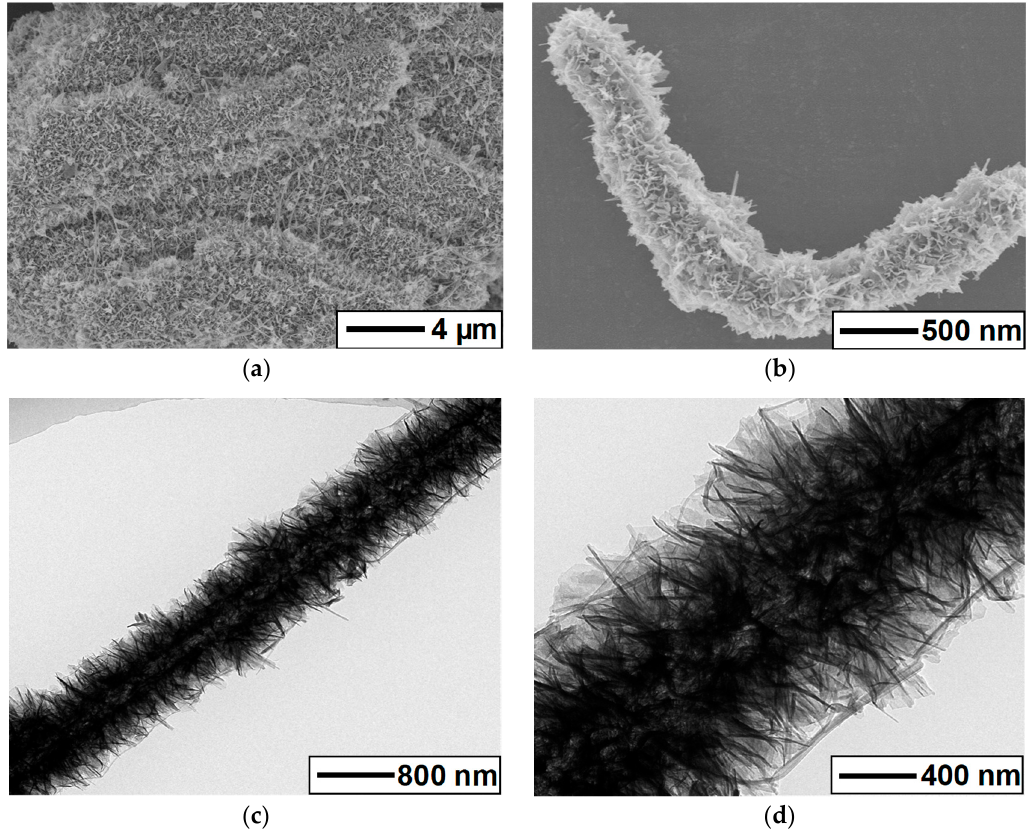
Figure 3. Electron micrographs of the MnO 2 -carbon-40.15% nanocomposite derived from a natural cellulose substance. ( a ) FE-SEM image of the sample, displaying nanofiber assemblies. ( b ) An individual composite nanofiber isolated from the assemblies. ( c , d ) The TEM images of an individual MnO 2 -carbon-40.15% nanofiber at different magnifications.